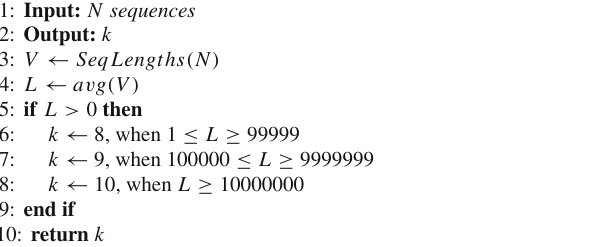
Algorithm 1 Dynamic selection of k value for k − mer